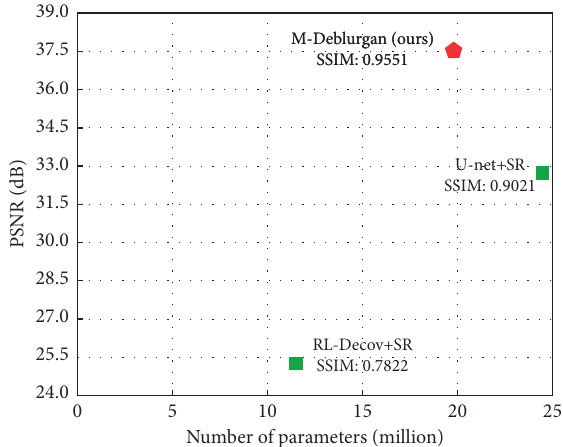
Figure 7: Comparison of PSNR and the model size of other methods on the PINE CONES dataset. The red pentagon is our